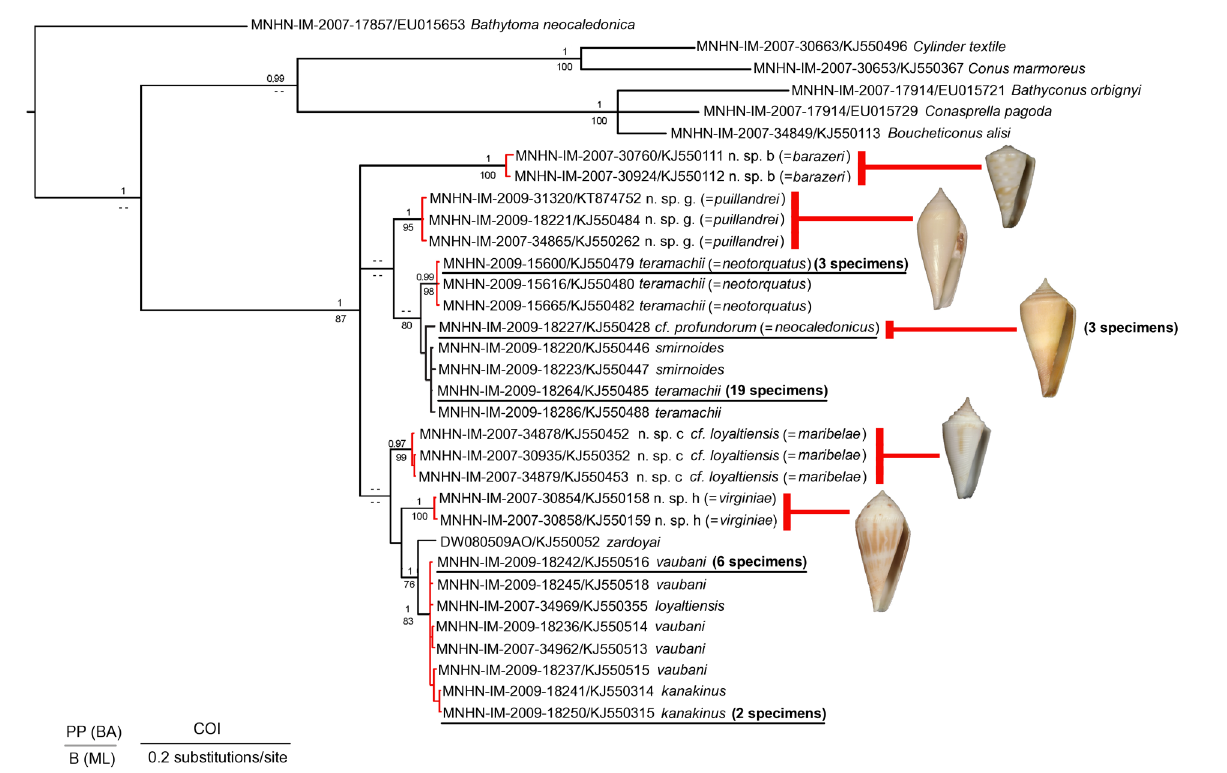
Fig. 5. Likelihood phylogenetic tree of Profundiconus Kuroda, 1956 based on a subsample of the mitochondrial cox1 dataset produced by Puillandre et al. (2014). Posterior probabilities and bootstrap values are indicated for each node (when PP ≥ 0.95% and BP ≥ 75%, respectively). For clarity purposes, external branches of phylogenetically highly supported species are highlighted in red in the consensus tree. Cox1 sequences are labelled using the MNHN voucher identification number, the Genbank accession number (when available), the species name and the number of specimens (or identical haplotypes) when greater than